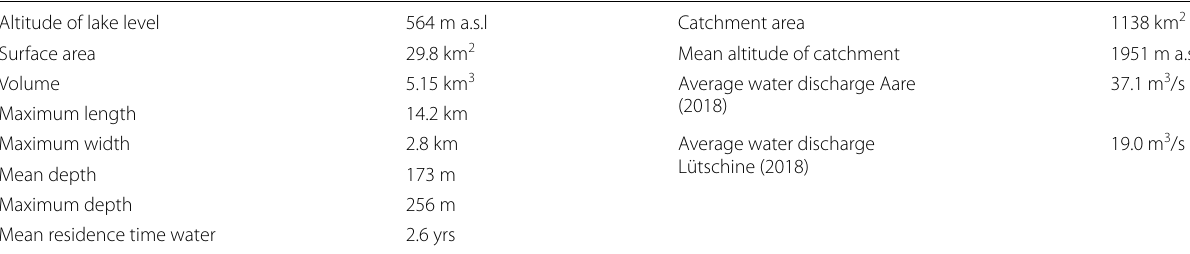
Table 1 Physical properties of Lake Brienz and its catchment (BAFU, 2016, 2018) Altitude of lake